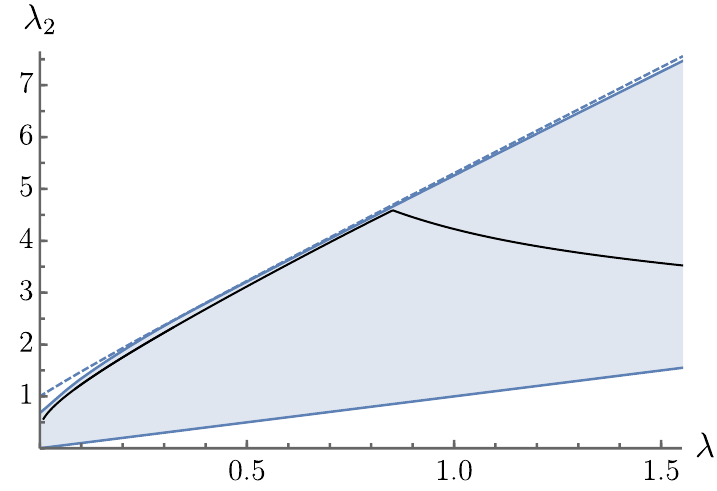
Figure 1 . An upper bound on the second positive eigenvalue of the Laplace-Beltrami operator on closed hyperbolic surfaces in terms of the first positive eigenvalue. The blue region is allowed by the numerical bound, where the lower bound is λ 2 ≥ λ 1 . The dashed line is the analytic bound (1.8). The black line corresponds to the eigenvalues of the family of genus-2 surfaces ρ ( ‘ ) , defined in eq. (4.16), for ‘ ∈ [15 / 4 , 20] , which were computed using the program Hypermodes by Strohmaier and Uski [9, 10]. The same bounds apply to any pair of consecutive nonzero eigenvalues of the Laplace-Beltrami operator on a closed hyperbolic